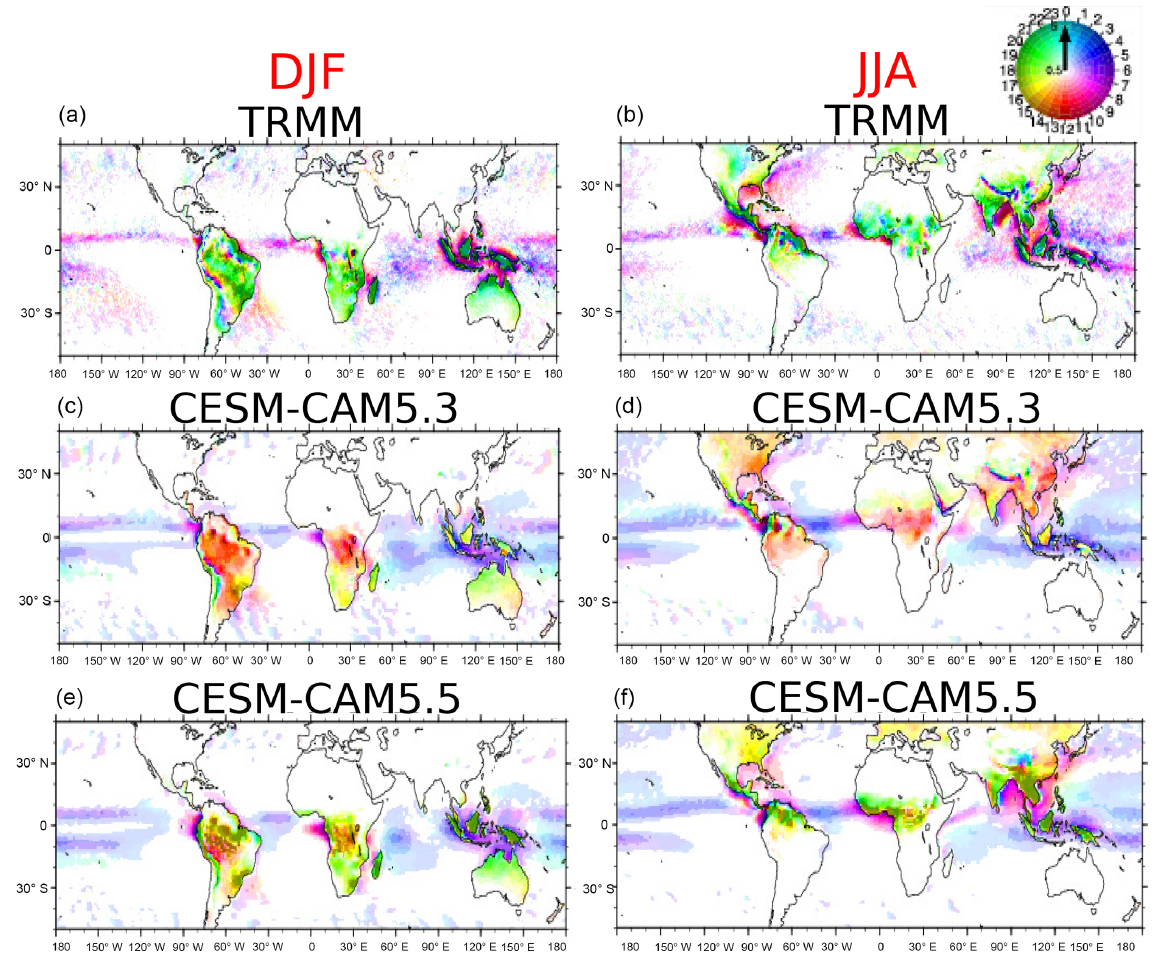
Figure 6. Diurnal cycle of precipitation maps for TRMM observations (a, b) , CESM-CAM5.3 (c, d) , and CESM-CAM5.5 (e, f) for December, January, February (DJF; a, c, e ) and June, July, August (JJA; b, d, f ). The color hue denotes the local time of day of the maximum precipitation rate, while the shading denotes the intensity of the